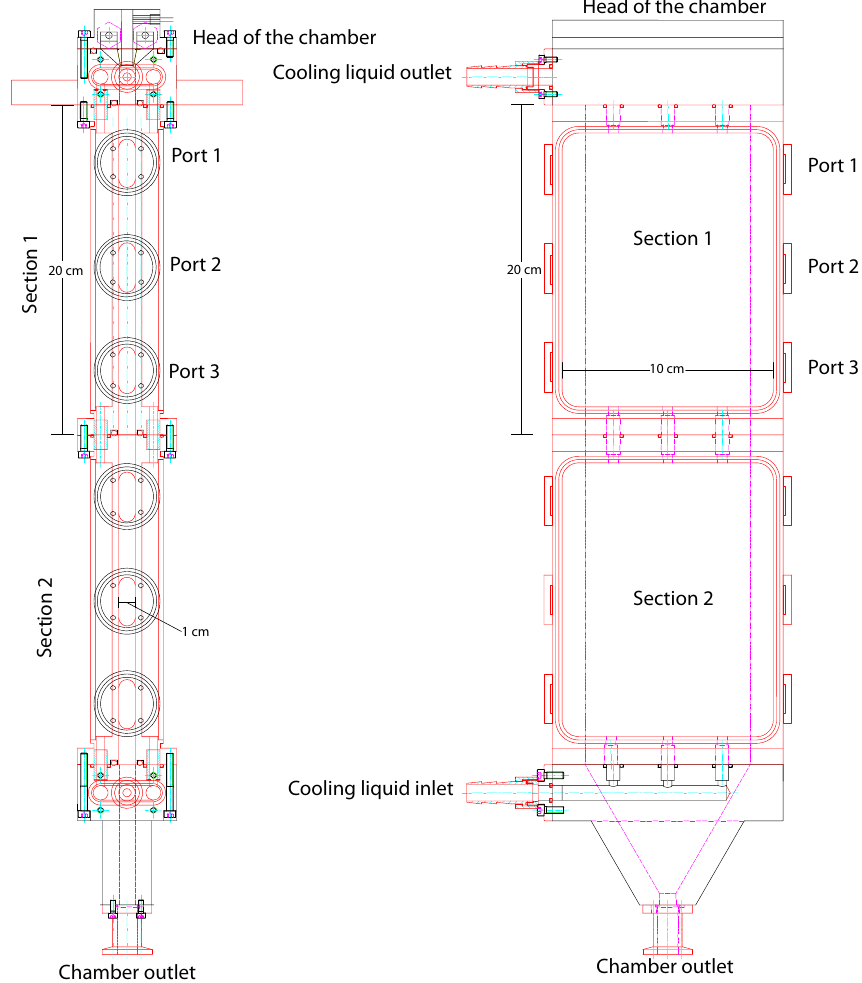
Fig. 10. Schematic with the CLINCH experimental setup; (left) side view and (right) front view of the instrument (Ladino, 2011).